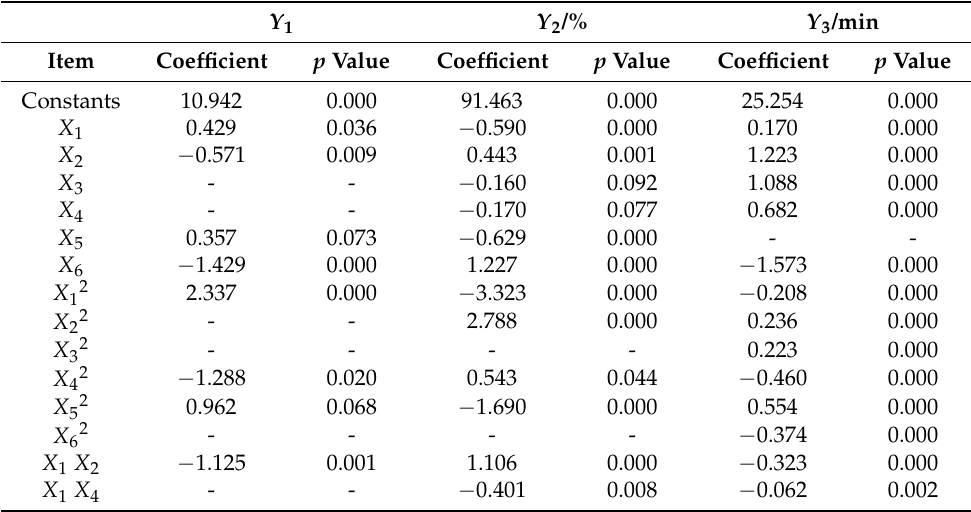
Table 5. Regression coefficients and ANOVA for each model.